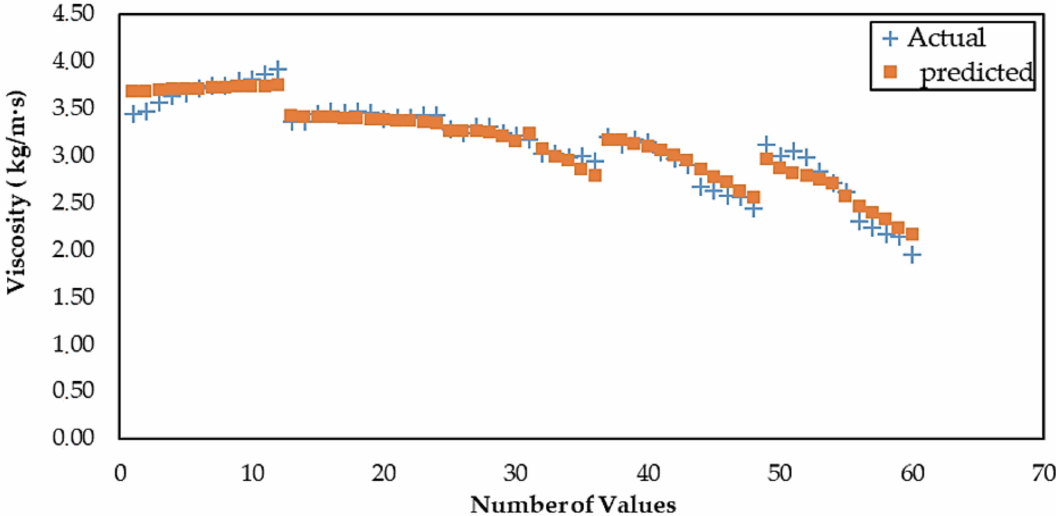
Figure 8. The actual viscosity values obtained with the experimental values and predicted viscosity values obtained using ADTree.